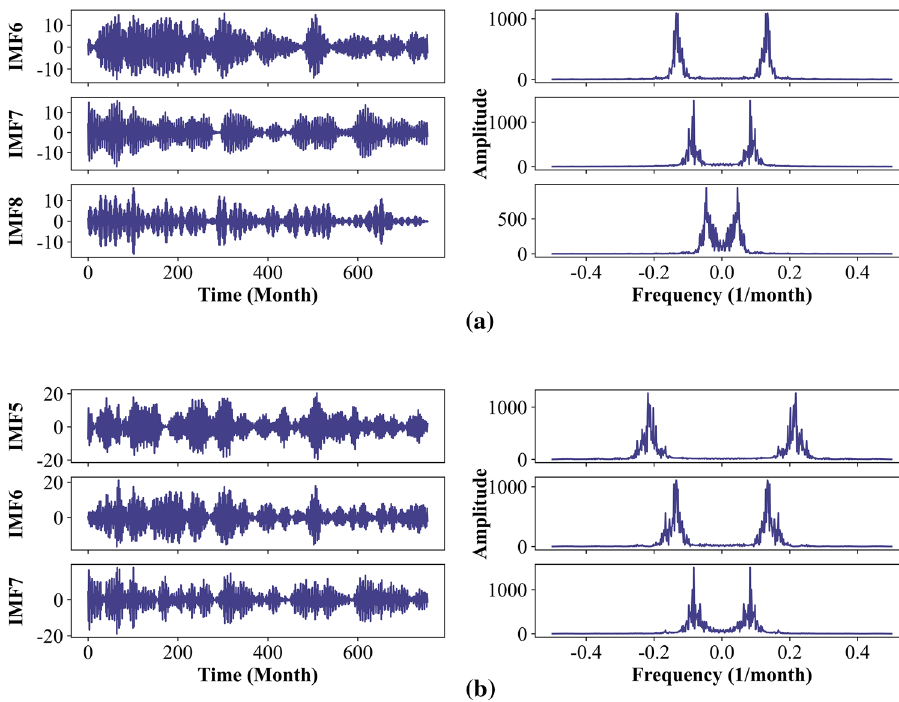
Fig. 9 Decomposition results and spectrum of WZ station when a K = 8, b K =